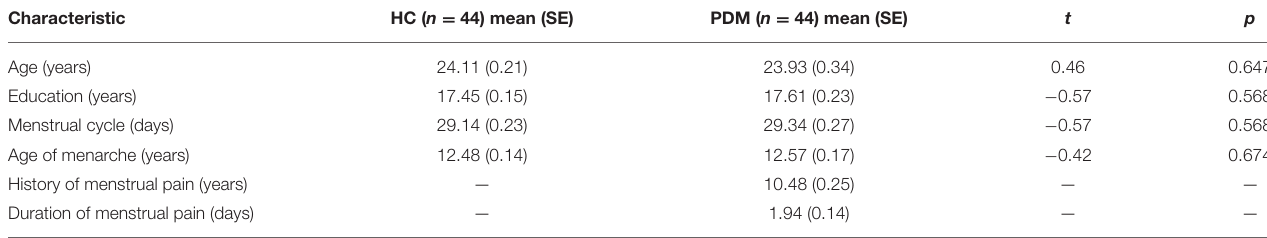
TABLE 1 | Demographics of the studied participants.